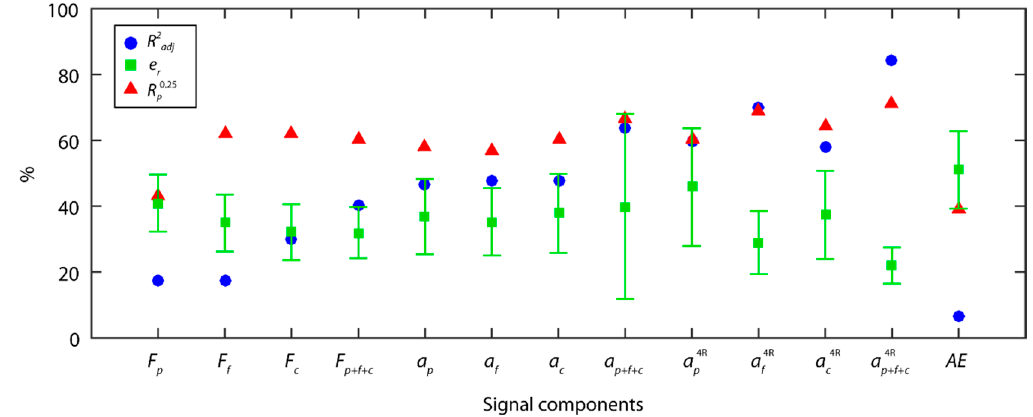
Figure 7. Signal analysis results with the PSD method.